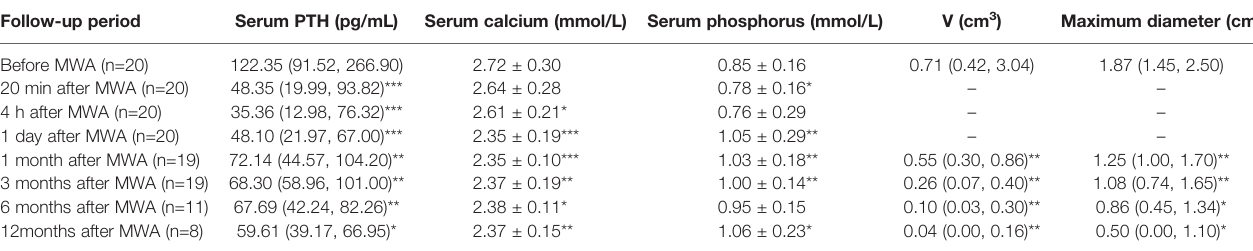
TABLE 3 | Changes in serum PTH, calcium, phosphorus levels, volume and the maximum diameter of parathyroid lesions in PHPT patients before and after MWA. Follow-up period Serum PTH (pg/mL) Serum calcium (mmol/L) Serum phosphorus (mmol/L) V (cm 3 )